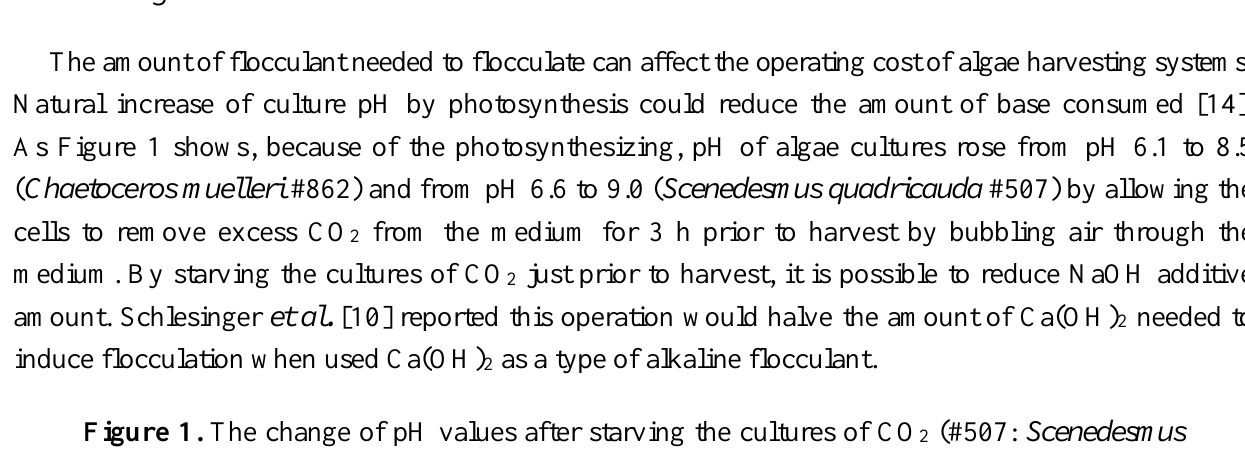
Figure 1. The change of pH values after starving the cultures of CO 2 (#507: Scenedesmus quadricauda #507 and #862: Chaetoceros muelleri